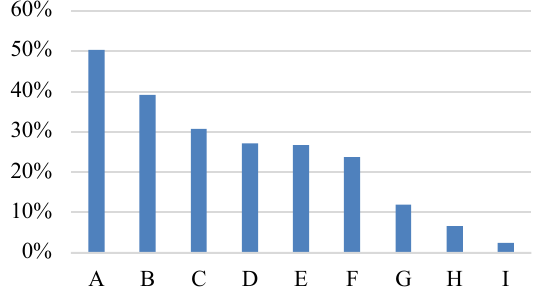
Fig. 5. Difficulties in installing and producing renewable energy.